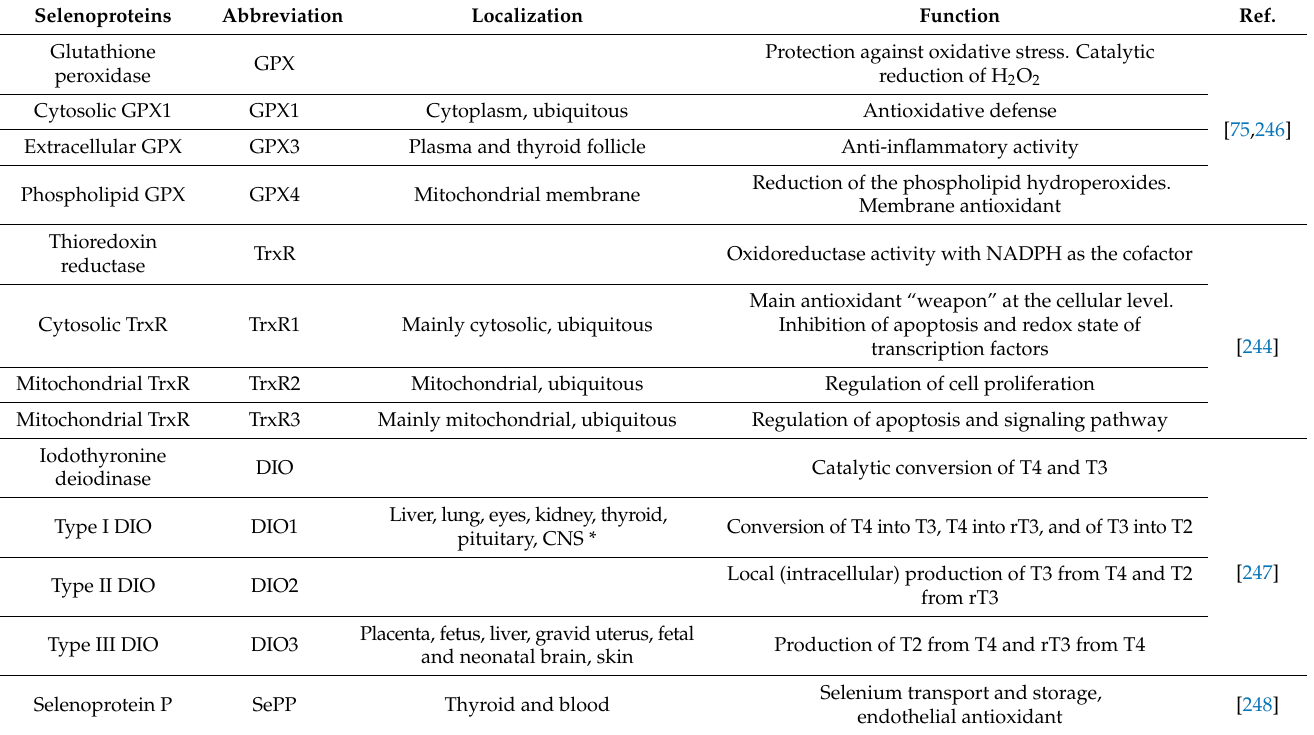
Table 2. Main types of selenoproteins and their